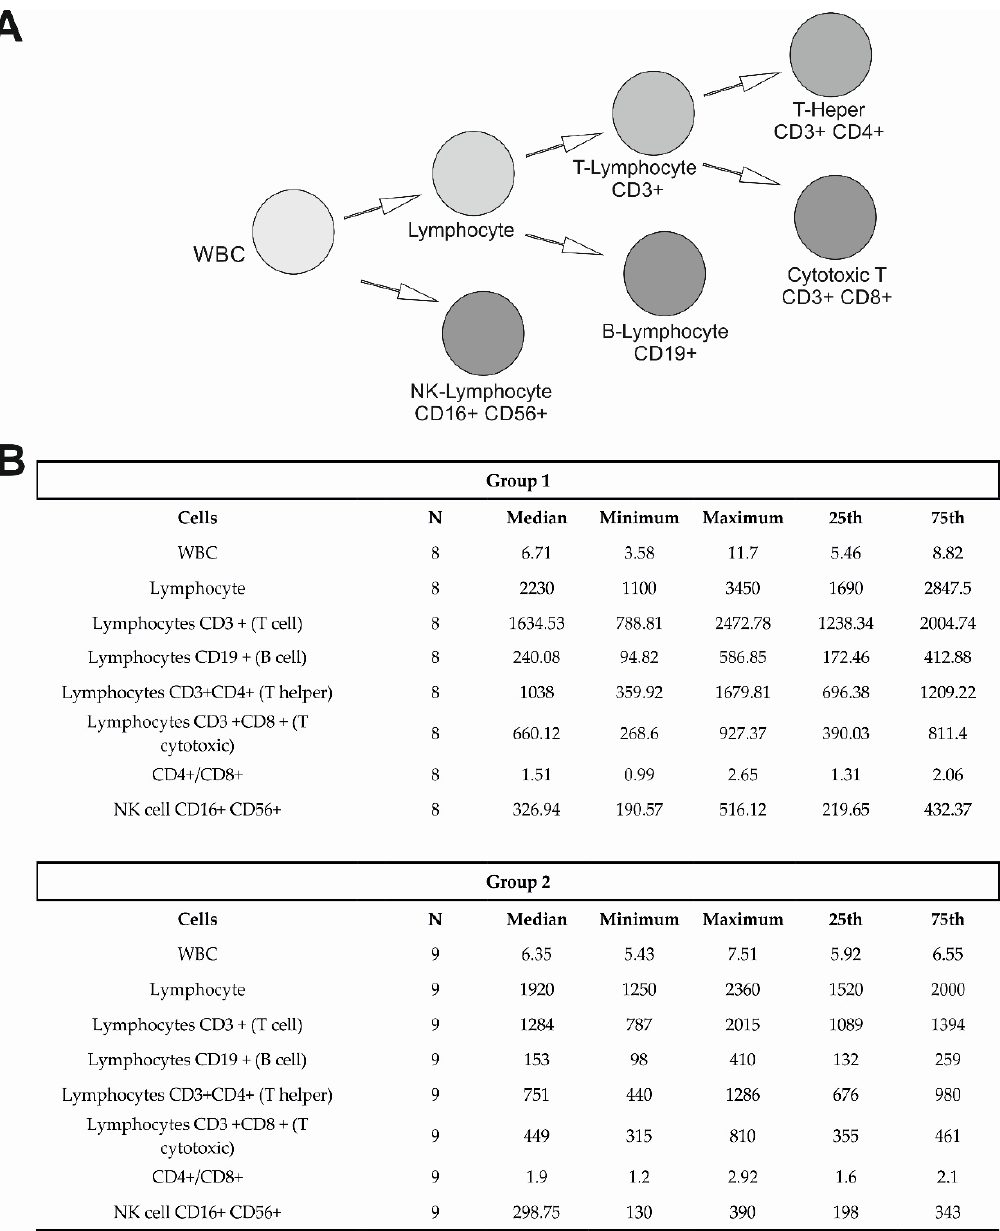
Figure 3. ( A ) The lymphocyte population that was examined. ( B ) Lymphocyte populations that were analyzed. The table reports the median, the interquartile range (25th and 75th percentiles), and the minimum and maximum values. It was observed no significant difference in all the lymphocyte classes. (WBC: white blood cells; NK: Natural Killer; T: thymocytes; B: Bone marrow cells).